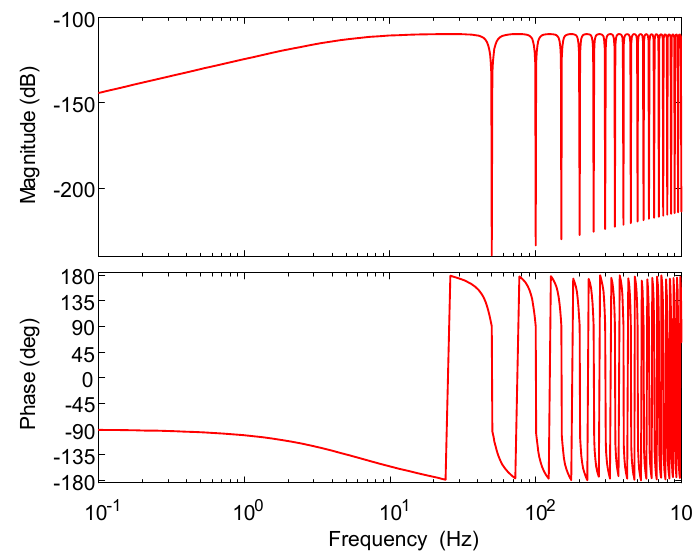
Figure 3. Bode plot of harmonic error x 3 a ( s ) with plugin-repetitive sliding mode control (RCSMC). From Figure 3, the error x 3 a ( s ) has a large attenuation at the fundamental frequency and the harmonic frequency when RCSMC is applied, and the amplitude gain is less than − 200 dB. Therefore, any harmonic error can be attenuated when the filter parameters are changed. Similarly, for other defects in the system model, the harmonic tracking errors can also be eliminated. It is proved that adding an RC term to the sliding surface can replace the multiple resonance term and play a better role in error correction. Obviously, the SAPF system based on RCSMC can not only enhance robustness, but also achieve full harmonic compensation and further reduce steady state errors. The A-phase control block diagram of the SMC system with RC term is shown in Figure 4. In Figure 4, an RC term of harmonic current error x 3 a is introduced to the sliding mode surface. The repetitive controller transfer function G RC ( s ) can achieve the best harmonic compensation by reasonably adding a compensator C ( z ) when the discrete implementation. According to [24], the compensator C ( z ) is composed of three parts: proportional gain k r , phase lead z k , and filter S ( z ). For the system parameters in this paper, the compensator is designed as [24]: